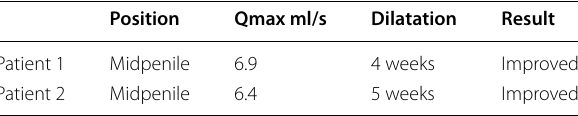
Table 3 Characteristics of patients of subcoronal tightening Position